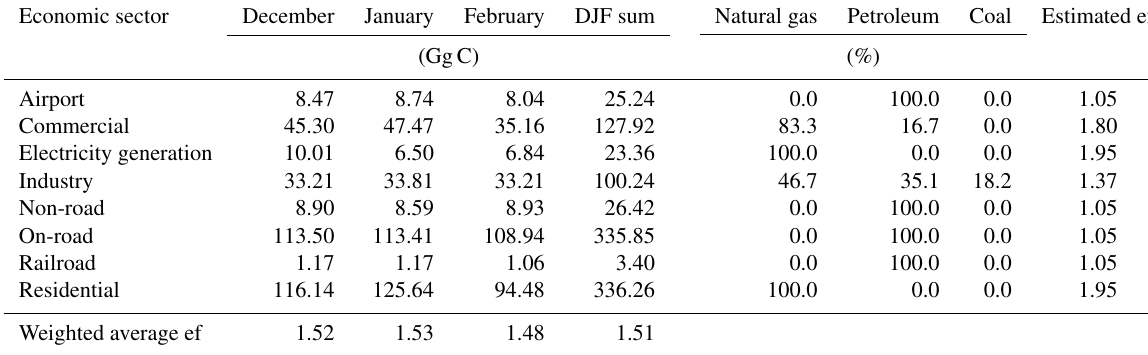
Table 1. HESTIA Emissions Estimates and estimated ef values for Salt Lake County. Economic